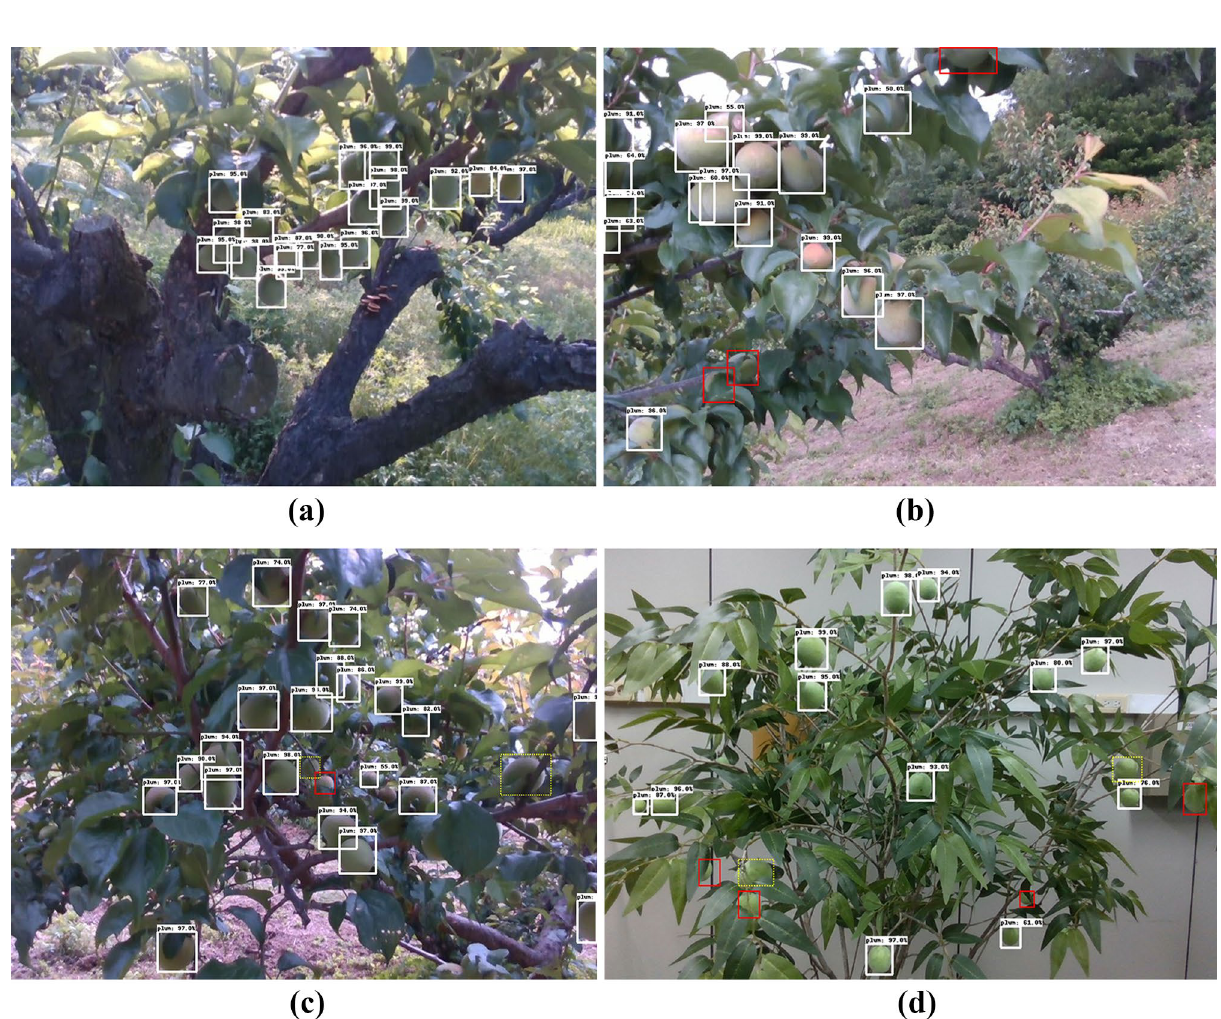
Figure 3. Detection results of EfficientDet D4 detection